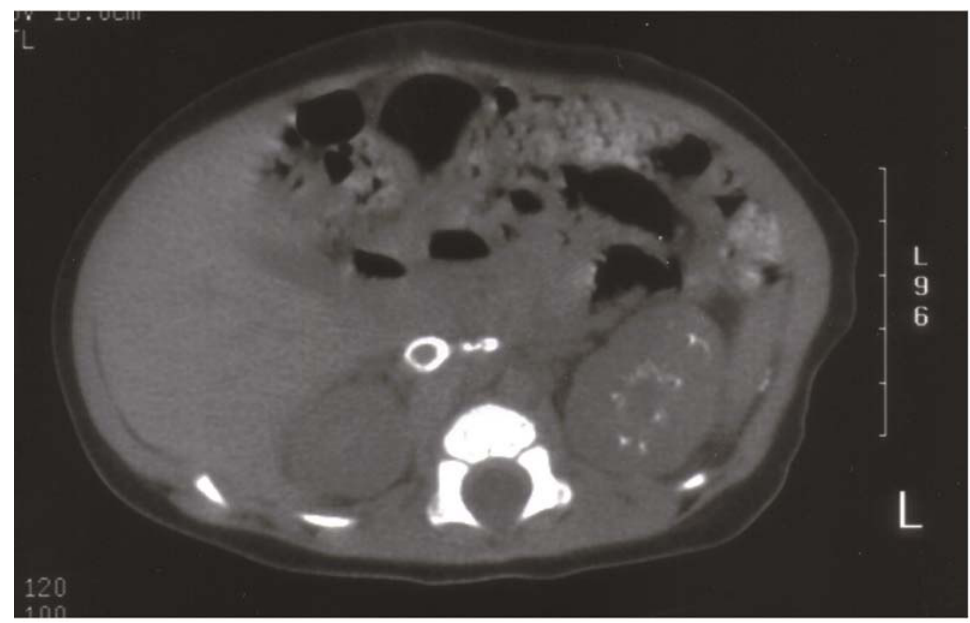
FIGURE 1. CT scan of the abdomen presenting ring calcification of the IVC with involvement of the renal